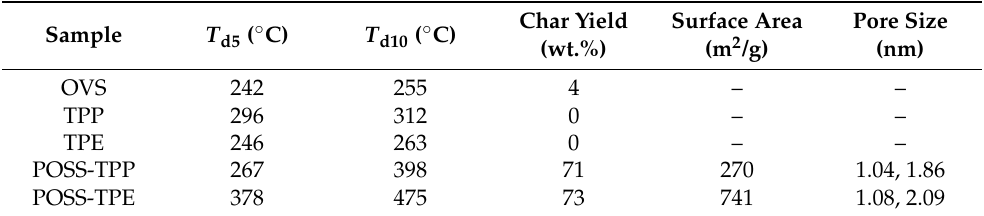
Table 1. Thermal stability and porosity properties of OVS, TPP, TPE, and their corresponding polymers.